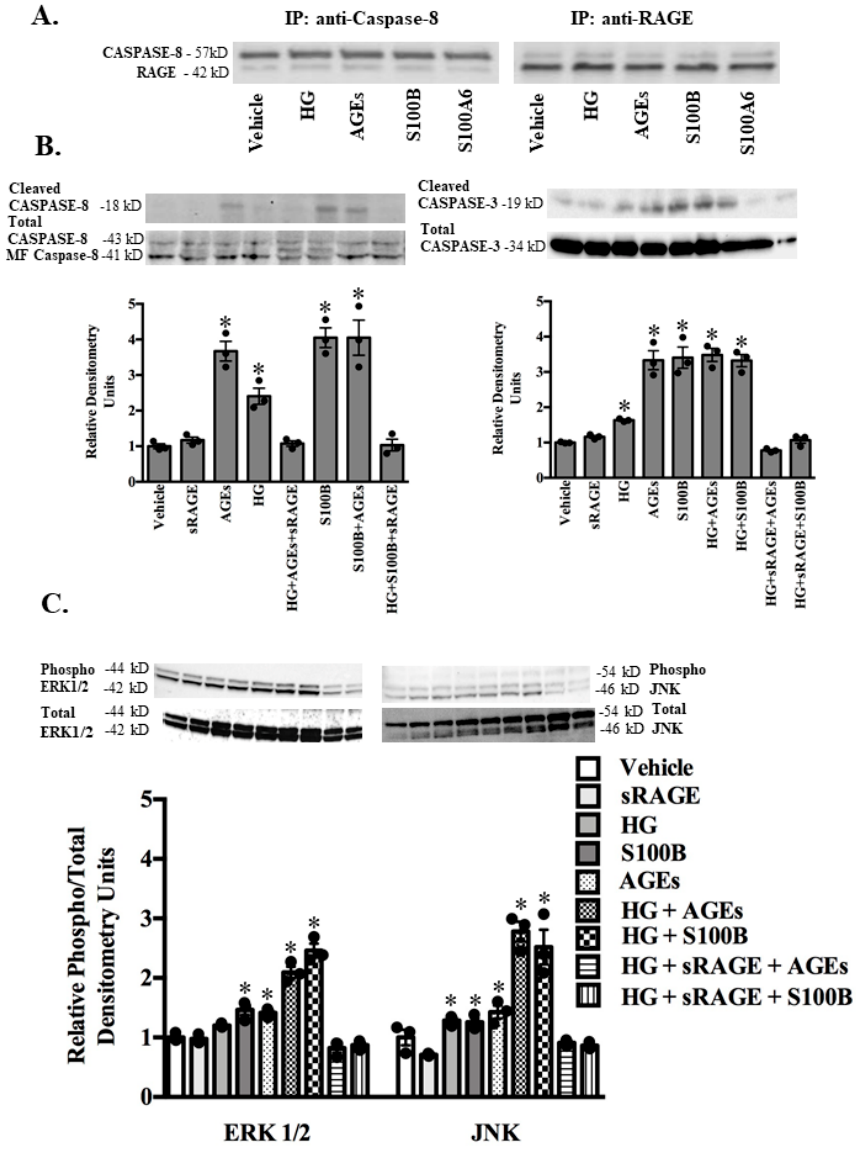
Figure 4. RAGE ligands regulate caspase-3, -8 activation and MAPK (ERK1/2, JNK) signaling. Cultured adult rodent abdominal aortic smooth muscle cells were exposed to vehicle (PBS), sRAGE (1.5 ng/mL), high glucose (HG) (4.5 g/mL), AGEs (50 μ g/mL) or S100B (100 pg/mL) alone or in combination with sRAGE for 24 h. Representative immunoprecipitation assay showing an association of RAGE and caspase-8 following treatment with vehicle (PBS), high glucose (HG), AGEs or S100B ( A ). Representative Western blots show cleaved, mid-form (MF) and total caspase-8, cleaved and total